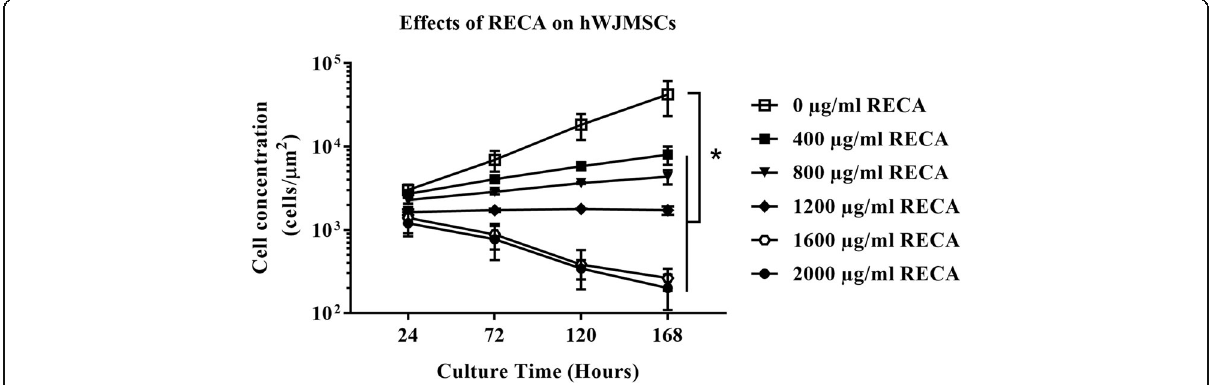
Fig. 5 The anti-proliferative of RECA on hWJMSCs. The hWJMSCs were treated with varying concentrations of RECA for 168h and the cell proliferation was assessed at different time intervals, which is after 24, 72, 120 and 168h of RECA treatment. The proliferation rate of hWJMSCs was significantly reduced after 168h of treatment with various concentrations of RECA compared to untreated hWJMSCs, which proliferated throughout the culture period, * p <0.05 ( n